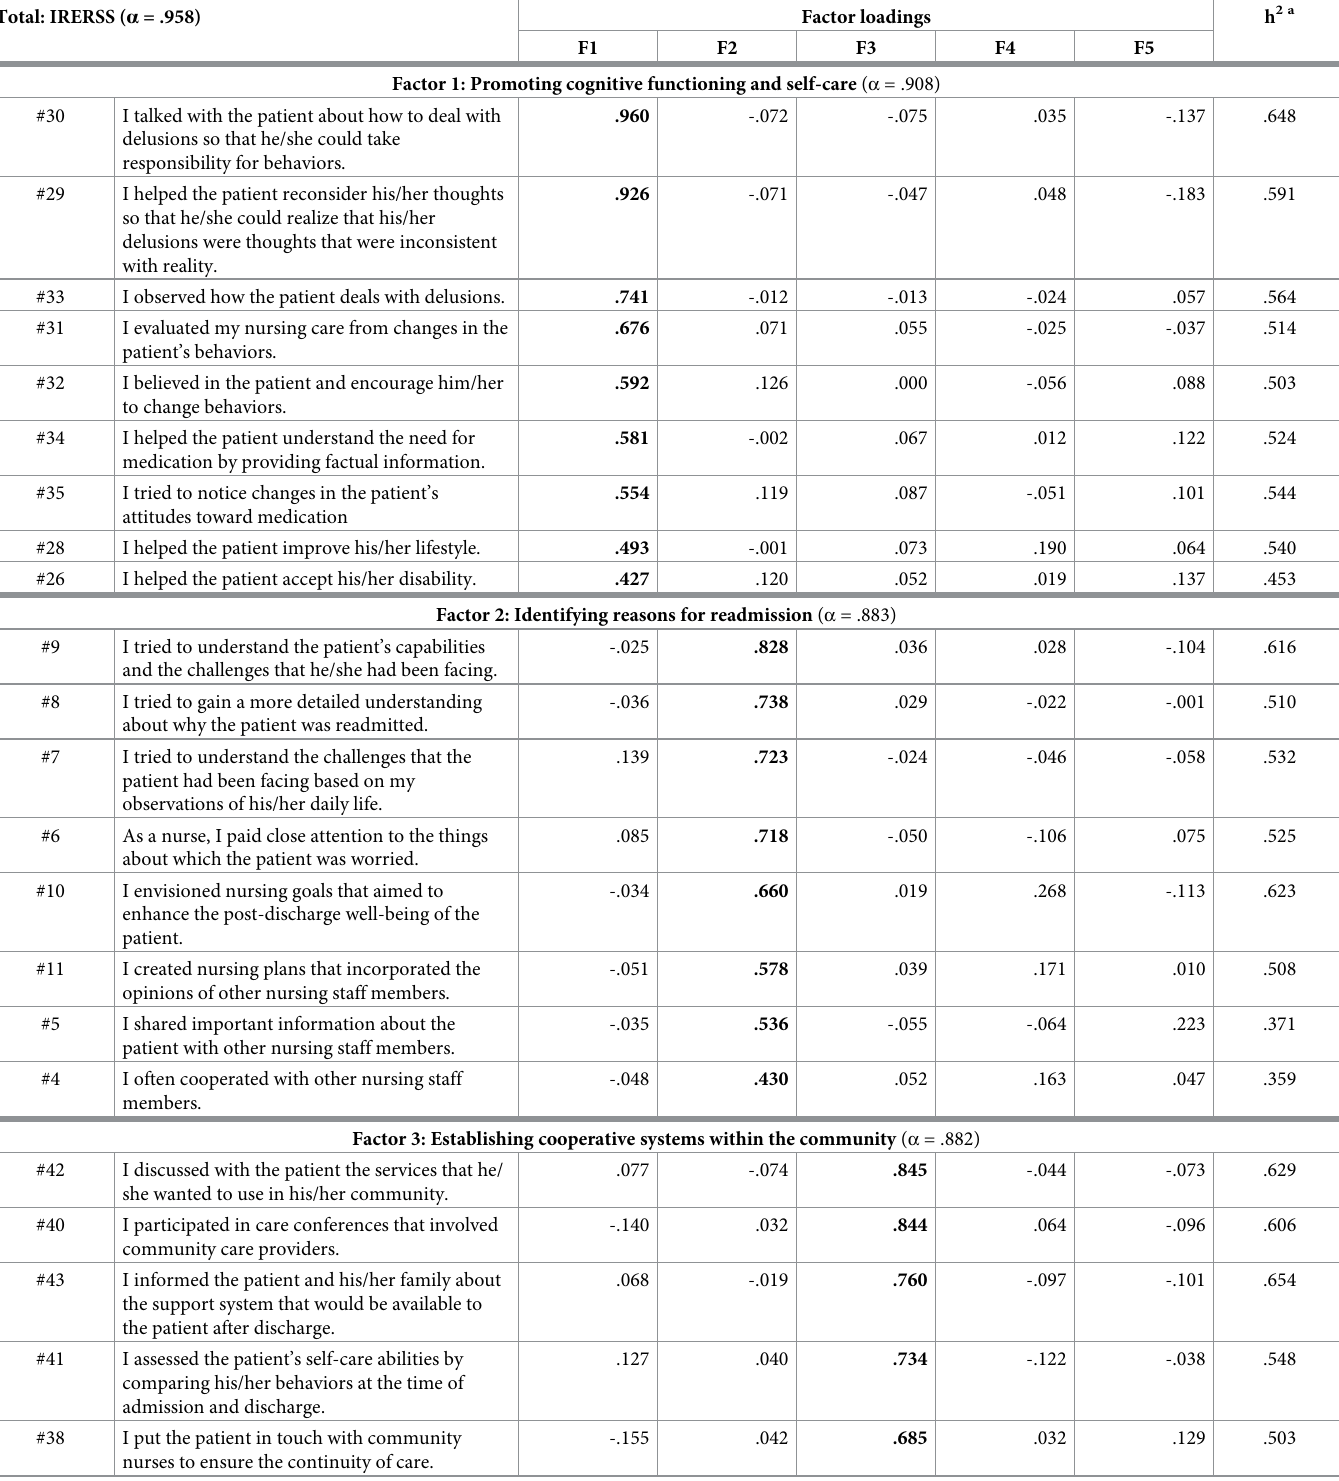
Table 2. Exploratory factor analyses and internal consistency of the IRERSS (n =